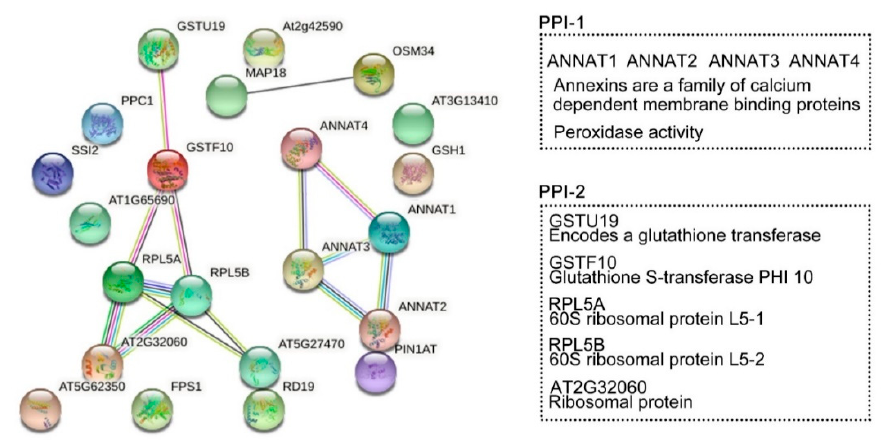
Figure 8. Protein-protein interaction (PPI) networks. STRING analysis using the HY2-specific regulated proteins under salt stress. Network nodes represent proteins. Edges represent protein–protein associations. Known interactions: from curated databases; experimentally determined. Predicted interactions: protein neighborhood; protein fusions; protein co-occur- rence.